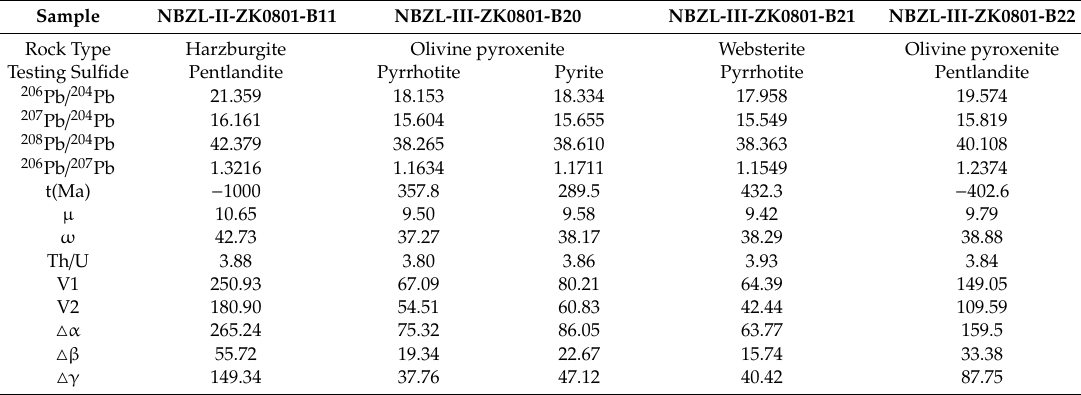
Table 3. The lead isotopes of sulfides from the Niubiziliang mafic-ultramafic